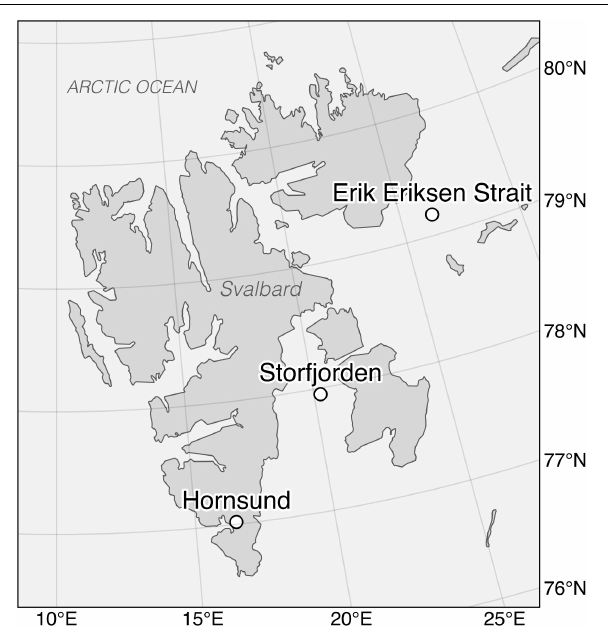
FIGURE 1 | Overview of the research locations Hornsund, Storfjorden and Erik Eriksen Strait during the Helmer Hanssen ArcEx cruise around Svalbard.